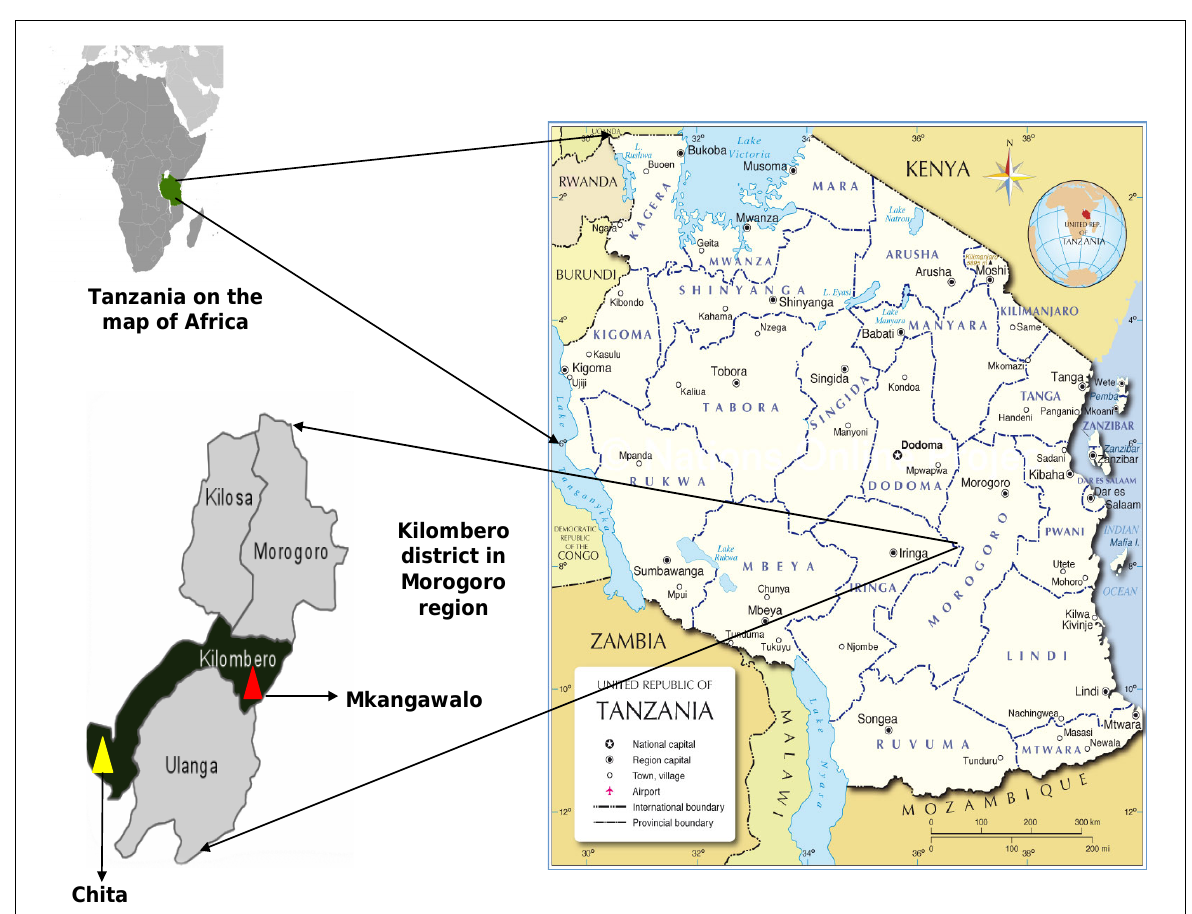
Figure 3. Map of Tanzania Showing the Study’s Location (Mkangawalo Village) and Control Site (Chita Village) in the Kilombero District of Morogoro